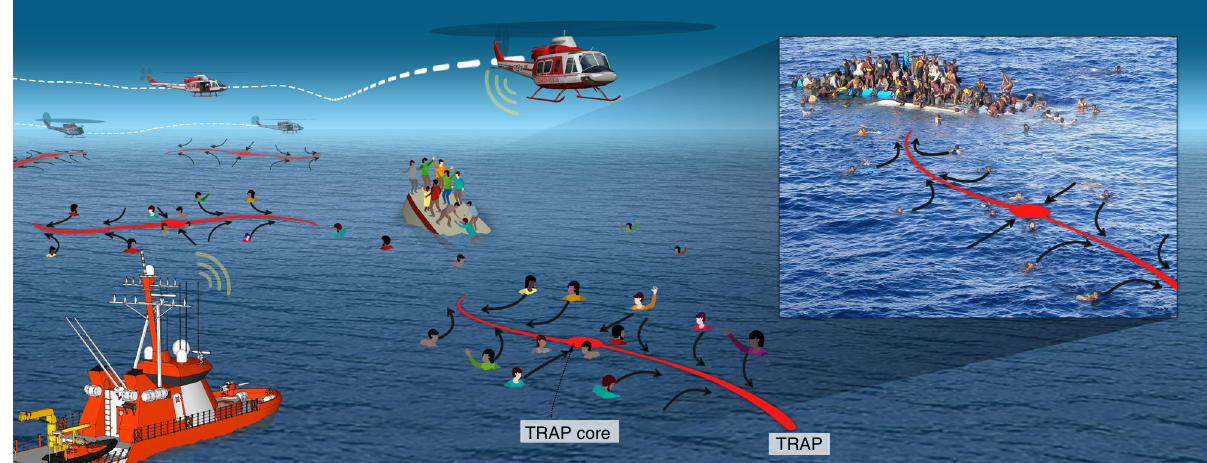
Fig. 1 Sketch of a TRAP-based SAR operation. TRAPs (red curves) emanate from an attracting core (red dot) where their normal attraction (black arrows) is maximal. Different TRAPs provide continuously updated and highly speci fi c search paths. The inset shows a migrant boat that capsized on 12 April 2015 in the Mediterranean Sea along with a schematic TRAP and persons in water. Photo credit: Opielok